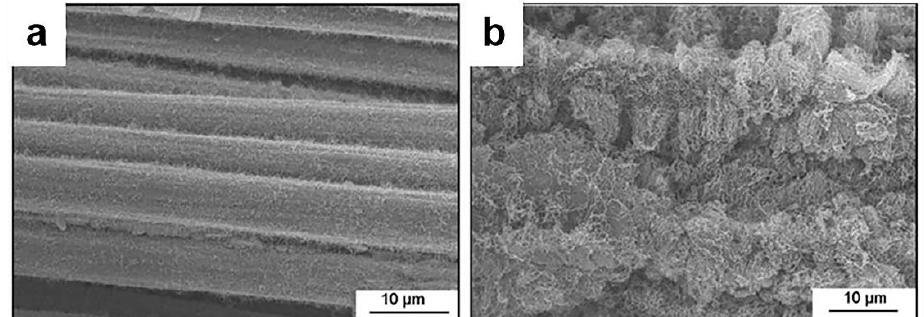
Figure 10. SEM images of the carbon fiber grown with ( a ) traditional thermal CVD and ( b ) modi- fied thermal CVD [113]. Copyright © 2021 Elsevier B.V. and New Carbon Materials.